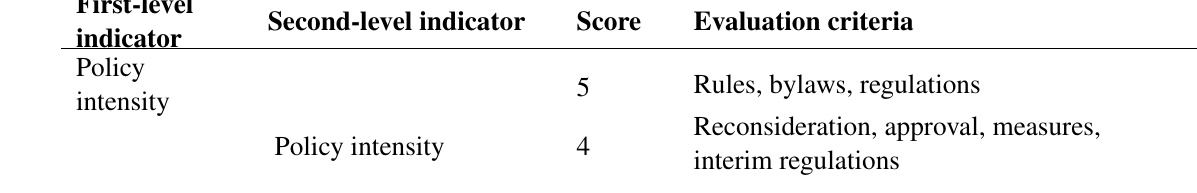
Table 2: Quantitative Standard Table of